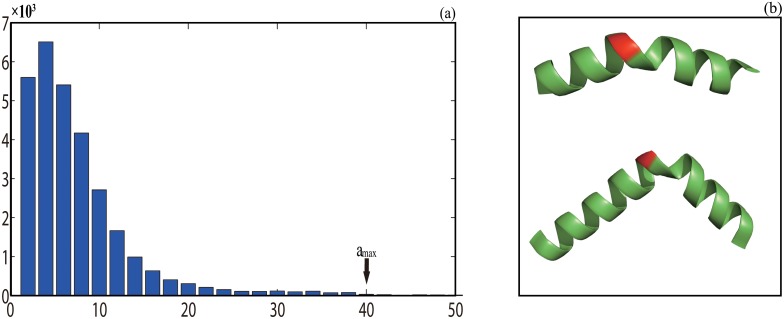
A histogram of helix axis angle a (a) and the threshold a
max (b).The x-axis in (a) is the angle in degree while the y-axis is the number of residues. In (b) the axis angle of residue 28 (colored in red and located in the middle of a segment, the top figure) in a protein (pdbid 4CXF) has a
28 = 37.72° while the angle of residue 53 (colored in red and located in the middle of a segment, the bottom figure) in a protein (pdbid 1SQG) has a
53 = 44.95°. With a threshold of a
max = 40.0°, the first segment is assigned by our algorithm as a single α-helix while the second segment is divided into two different helices. In contrast both segments are assigned as a single helix by dssp.